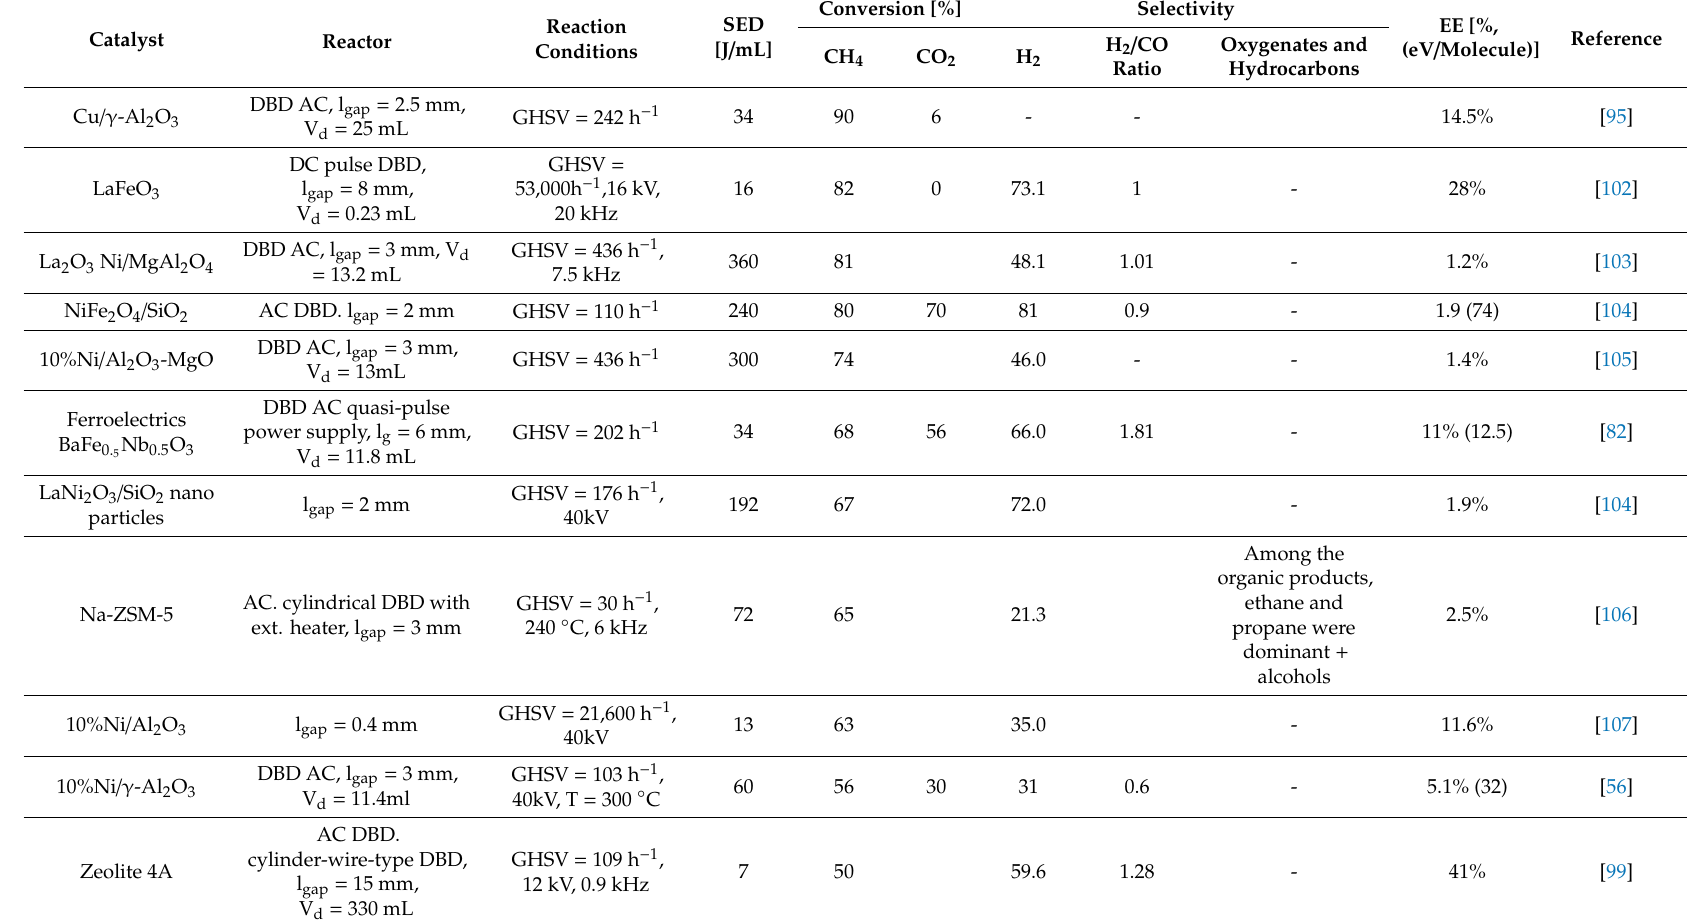
Table 7. An overview of di ff erent DMR catalysts used in DBD